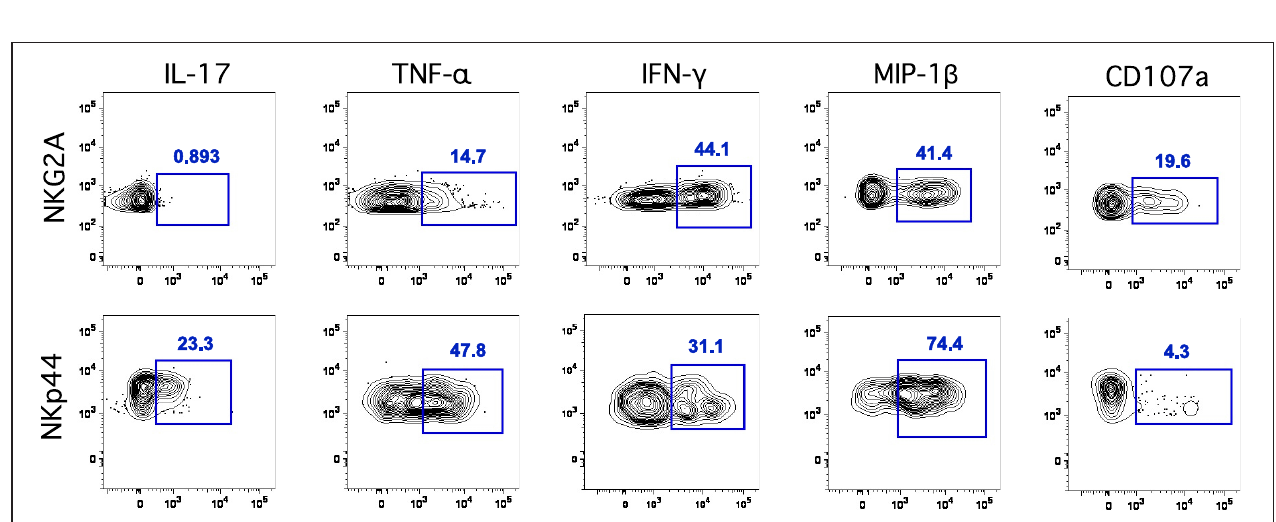
FIGURE 3 | Classical NK cells and ILCs in the oral mucosa have distinct functional profiles. Representative flow cytometry plots depicting CD107a and intracellular cytokine responses in NK cells and ILCs in the oral mucosa following mitogen stimulation. ICS profiles are representative of a total of 13 animals.